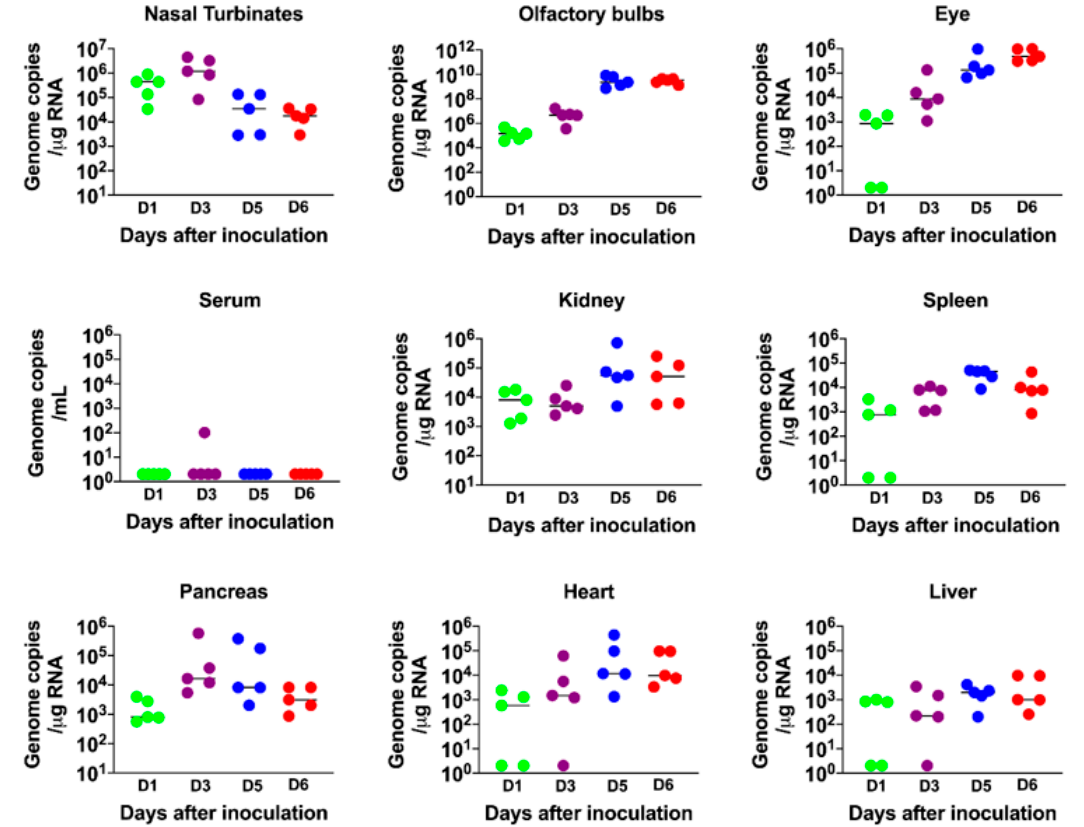
Figure 2. Analysis of virus tropism in K18-hACE2 mice. The viral RNA copy number in the nasal turbinates, olfactory bulbs, eye, serum, kidney, spleen, pancreas, heart and liver was determined on days 1, 3, 5 and 6 after infection by qRT-PCR and expressed as genome copies/ µ g of RNA. Each data point represents an individual mouse. The solid horizontal lines signify the median value.